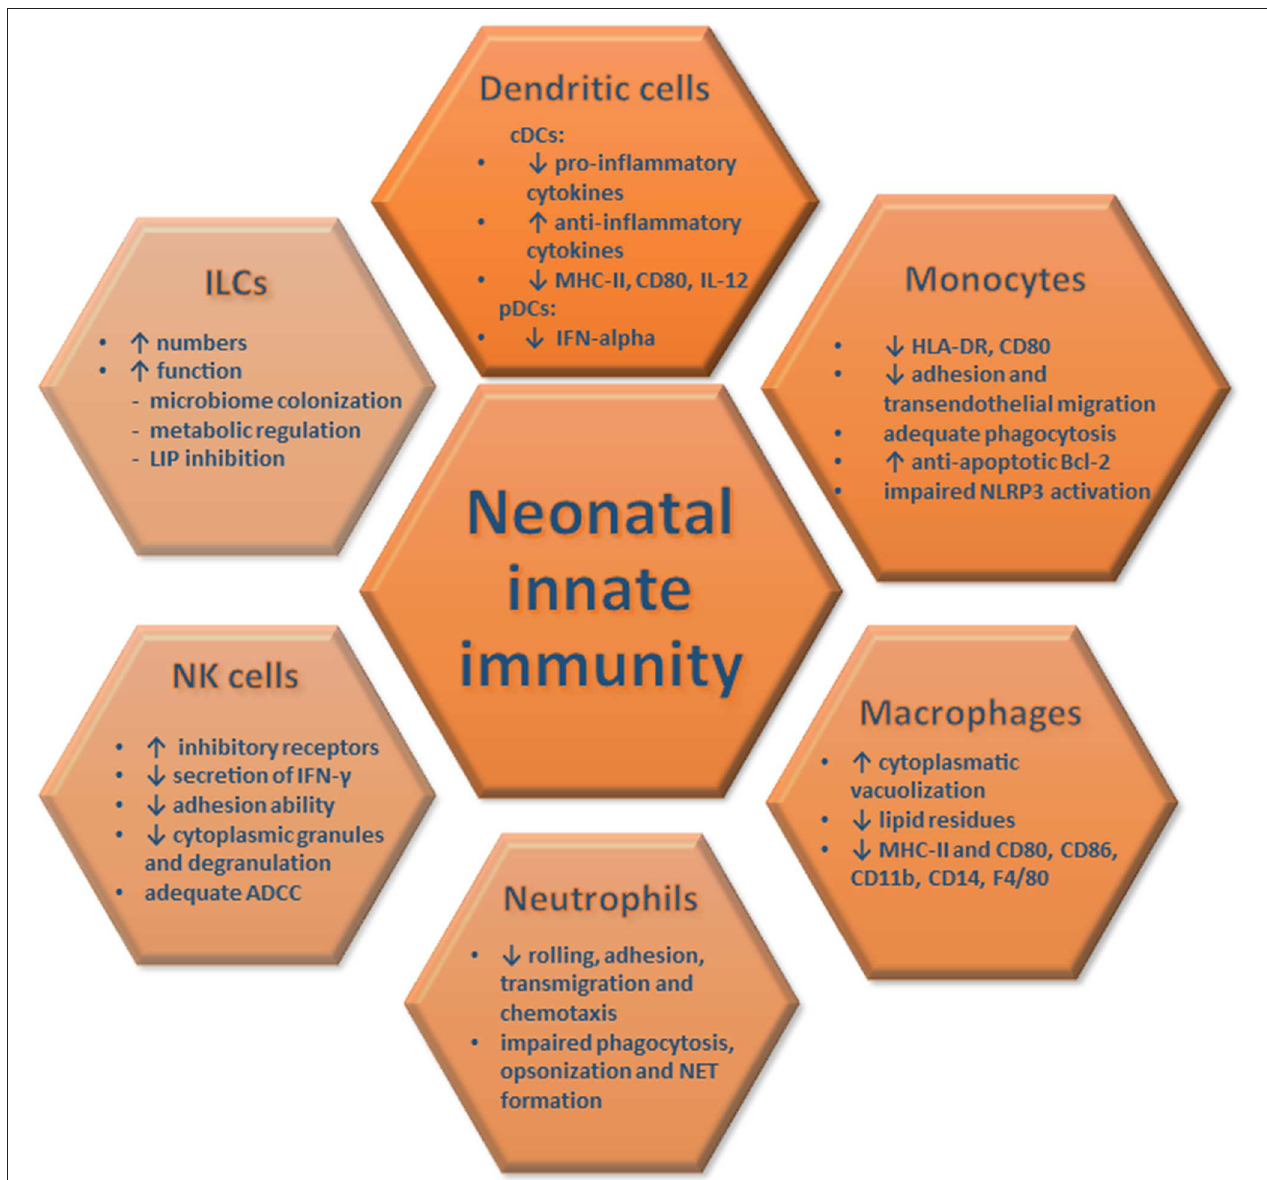
FIGURE 1 | Innate immune responses in neonates. The quantitative and functional characteristics of neonatal innate immune responses are depicted and compared to those of adults. These features of innate immune cells render newborns vulnerable to severe infections and organ